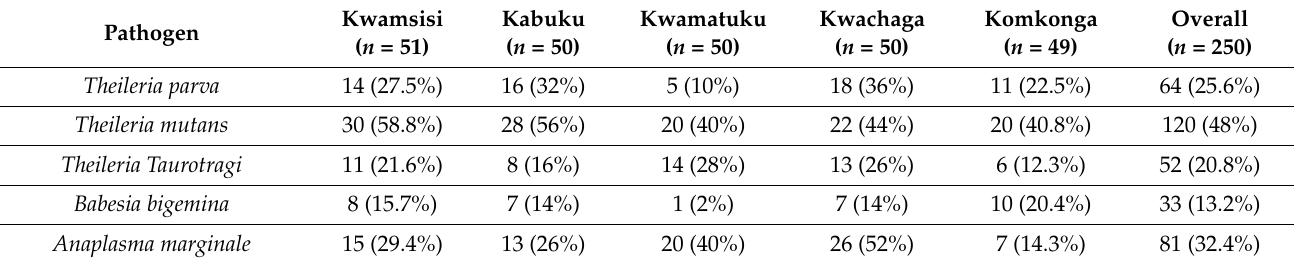
Table 3. Overall prevalence of the detected pathogens.